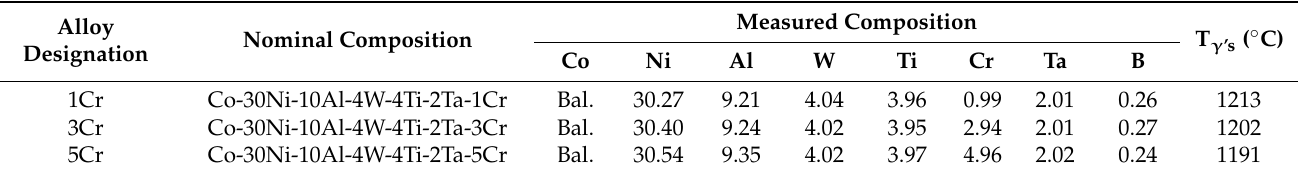
Table 1. Chemical composition (in at.%) of the investigated CoNi-based alloys and utilized